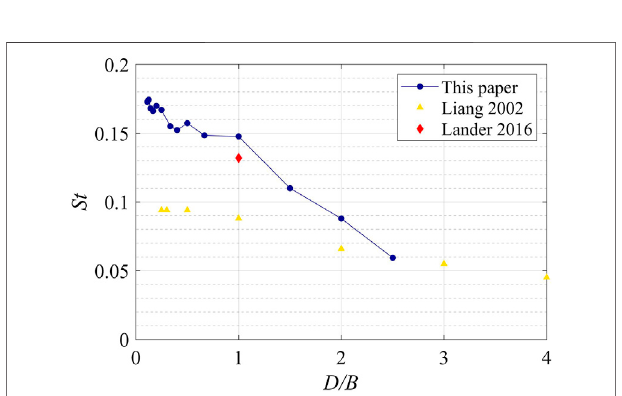
FIGURE 7 | Strouhal number as a function of D/B